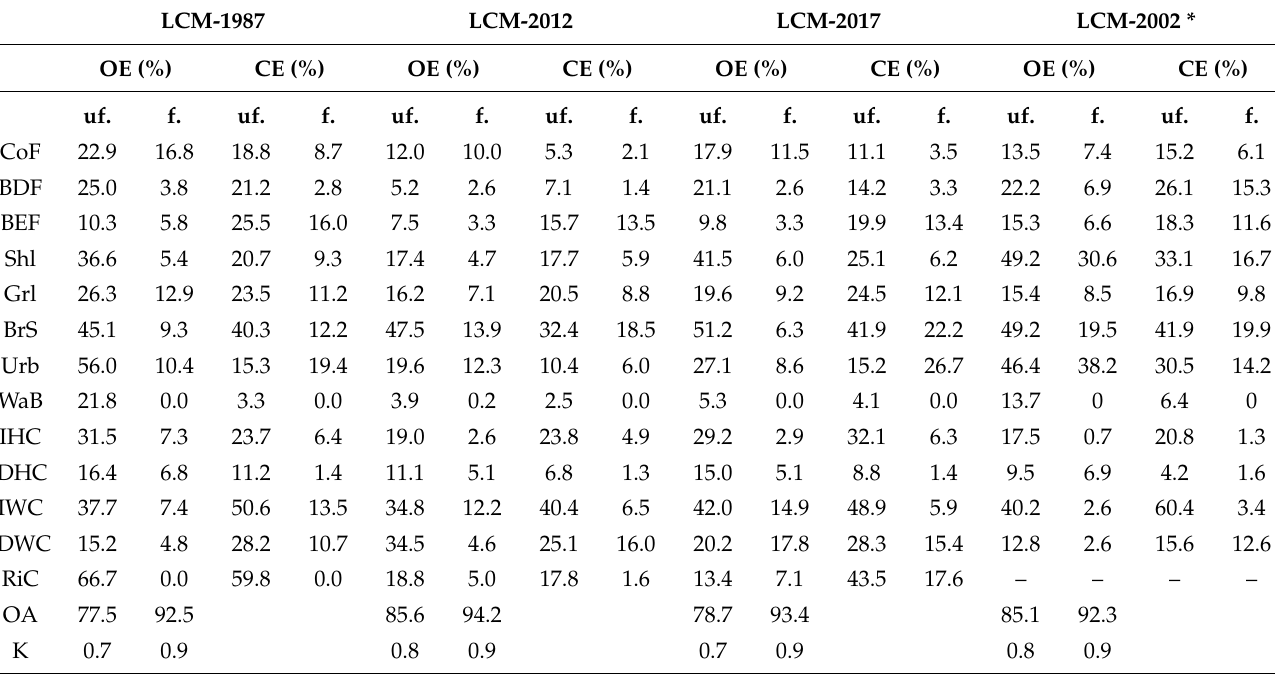
Table 4. Summary statistics of the confusion matrices considering unfiltered and filtered GT samples derived from SIOSE 2005 and 2011 in three temporal cases and one spatial